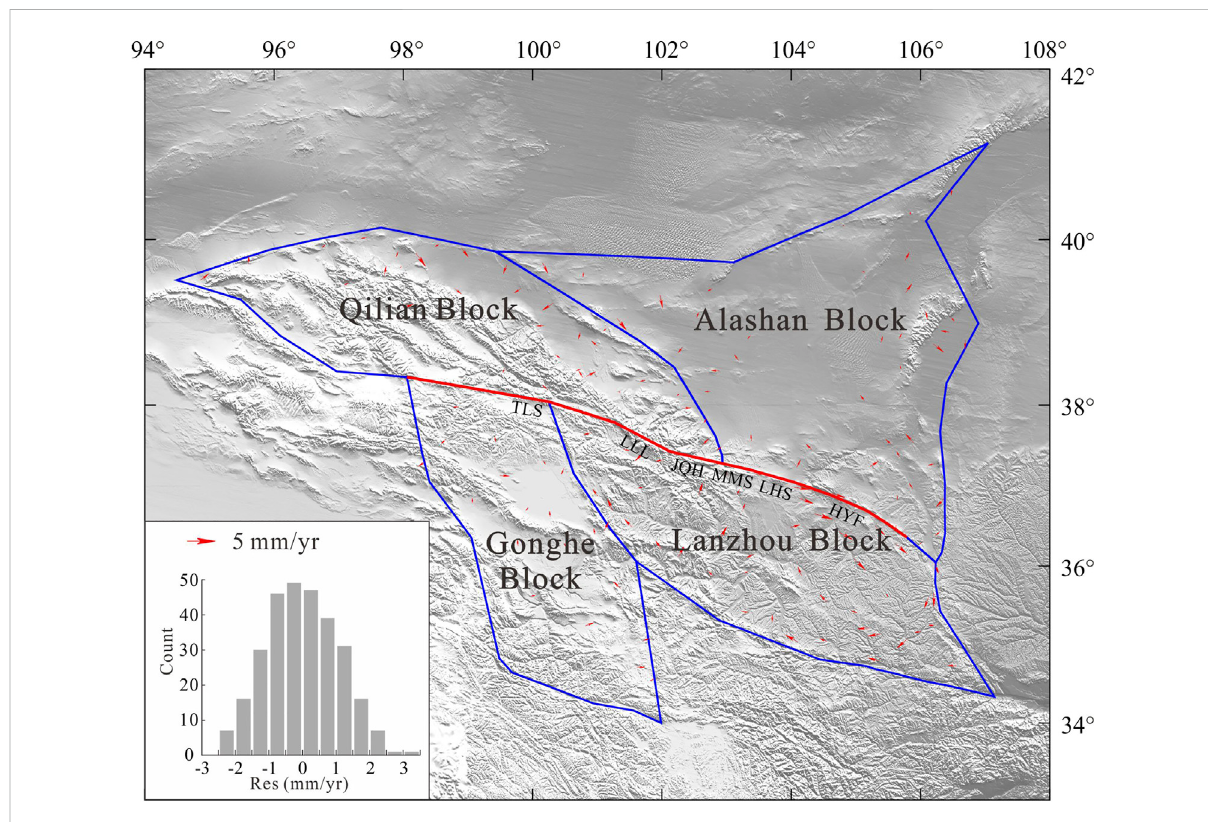
FIGURE 8 GPS velocity residuals associated with the block kinematic model and their statistical histogram. The red line is the Qilian – Haiyuan fault zone. The bluelines are active block boundaries.Red arrowsrepresent theGPS velocities residuals. TLSF: Tuolaishanfault; LLLF: Lenglonglingfault; JQHF: Jinqianghe fault; MMSF: Maomaoshan fault; LHSF: Laohushan fault; HYF: Haiyuan